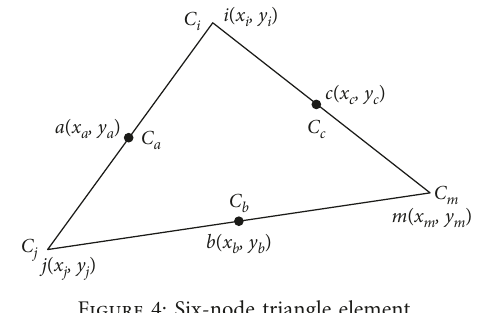
Figure 4: Six-node triangle